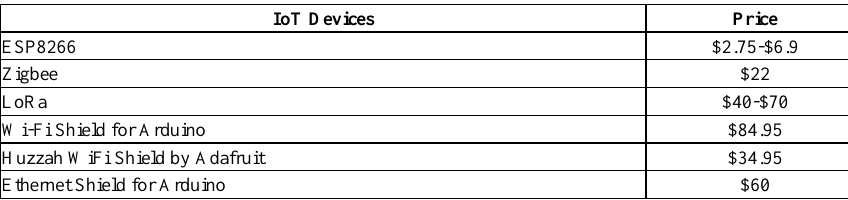
Table 1. Cost Comparison of Existing IoT Module